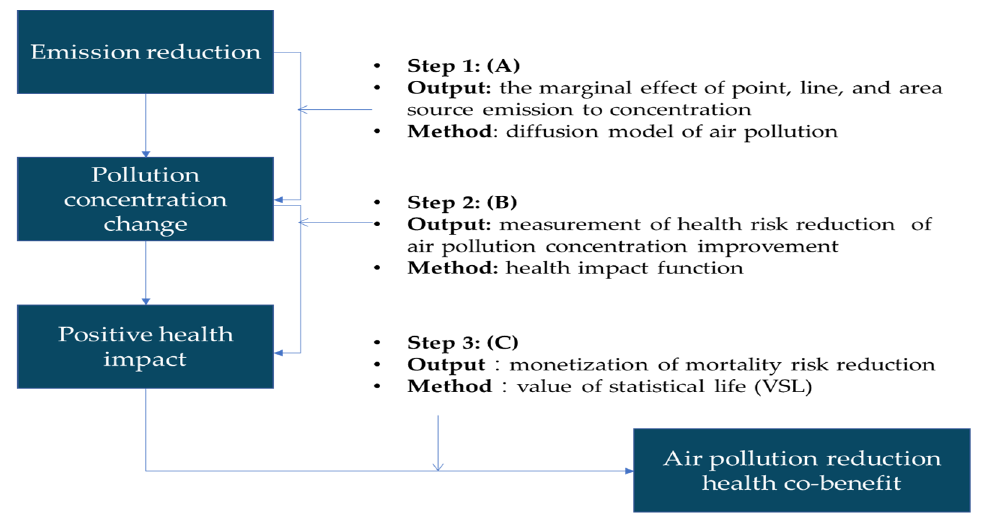
Figure 4. The evaluation of the monetary benefits of air pollution reduction through the IPA. Table 2. The effect of a one-ton pollution reduction for each pollutant on the concentration from different sources 1.